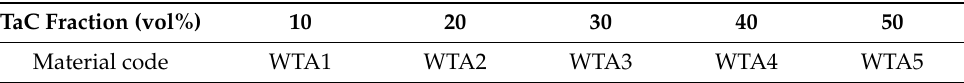
Table 1. Materials design and the codes of the composites. TaC Fraction (vol%)